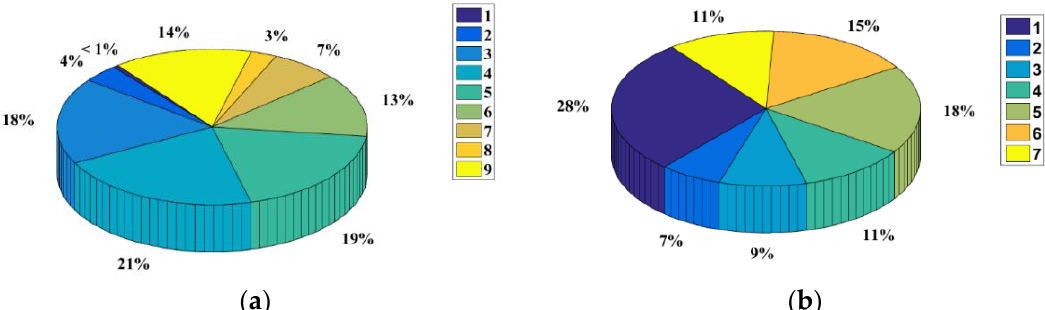
Figure 3. Percentages of passengers by topic model and shares of different classes: ( a ) percentages of passengers in different topics and ( b ) percentages of passenger clusters. Table 2. Parameter results.